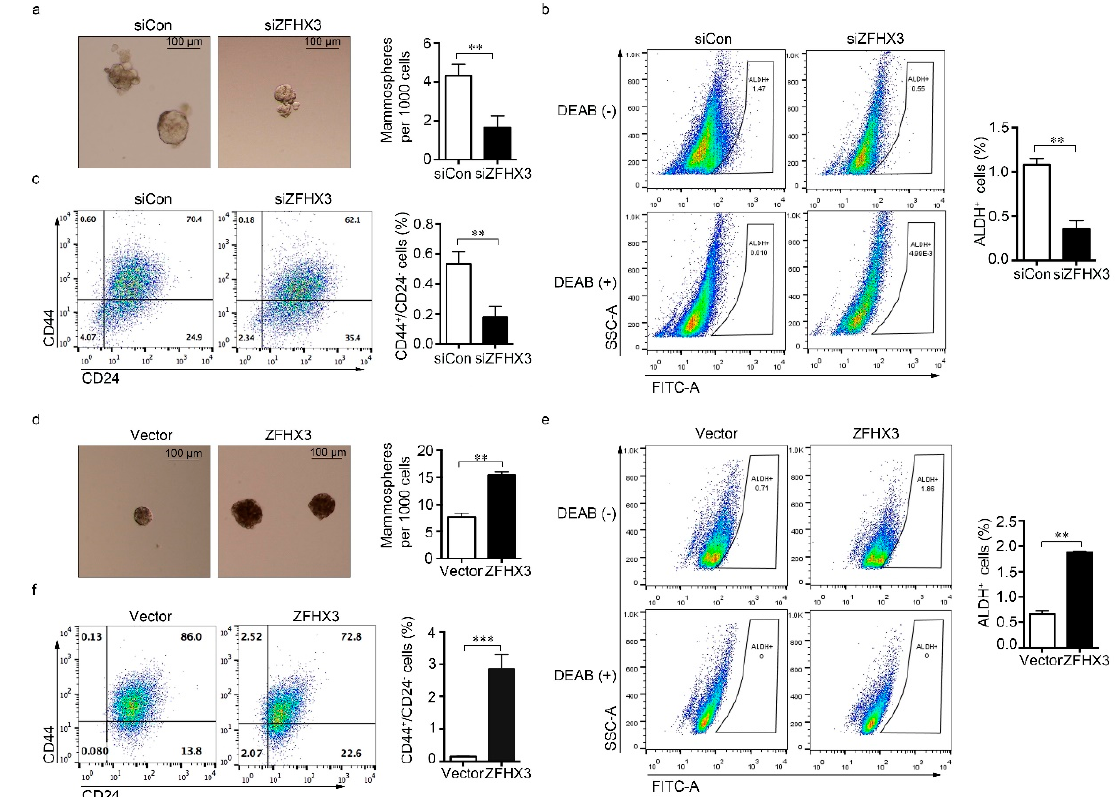
Figure 2. ZFHX3 maintains stem-like characteristics of ER + MCF-7 and T-47D breast cancer cells. ( a – c ) RNAi-mediated knockdown of ZFHX3 in MCF-7 cells decreased mammosphere forming ability ( a ), as indicated by images of mammospheres (left) and their quantification (right) from the mammosphere formation assay, and the populations of ALDH + ( b ) and CD44 + /CD24 − ( c ) cells, as analyzed by flow cytometry. ( d – f ) Ectopic expression of ZFHX3 in T-47D cells increased mammosphere forming ability ( d ) and the populations of ALDH + ( e ) and CD44 + /CD24 − ( f ) cells, as analyzed by flow cytometry. siCon, control siRNA; siZFHX3, siRNA against ZFHX3 . ** p < 0.01; *** p < 0.001. The blank and isotype controls are shown in Supplementary Figure S6.